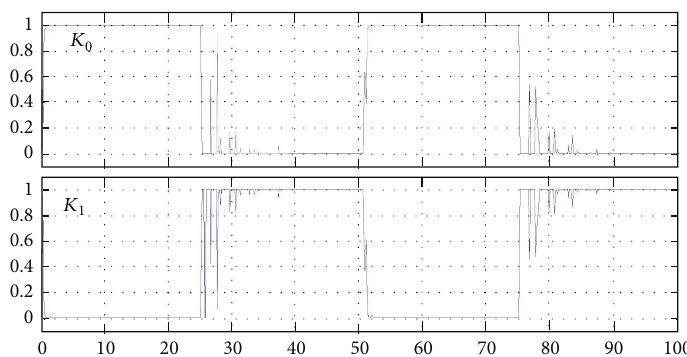
Figure 4: Time diagrams for confidence coefficients of technical states of an attitude control system of a space launch vehicle for independent